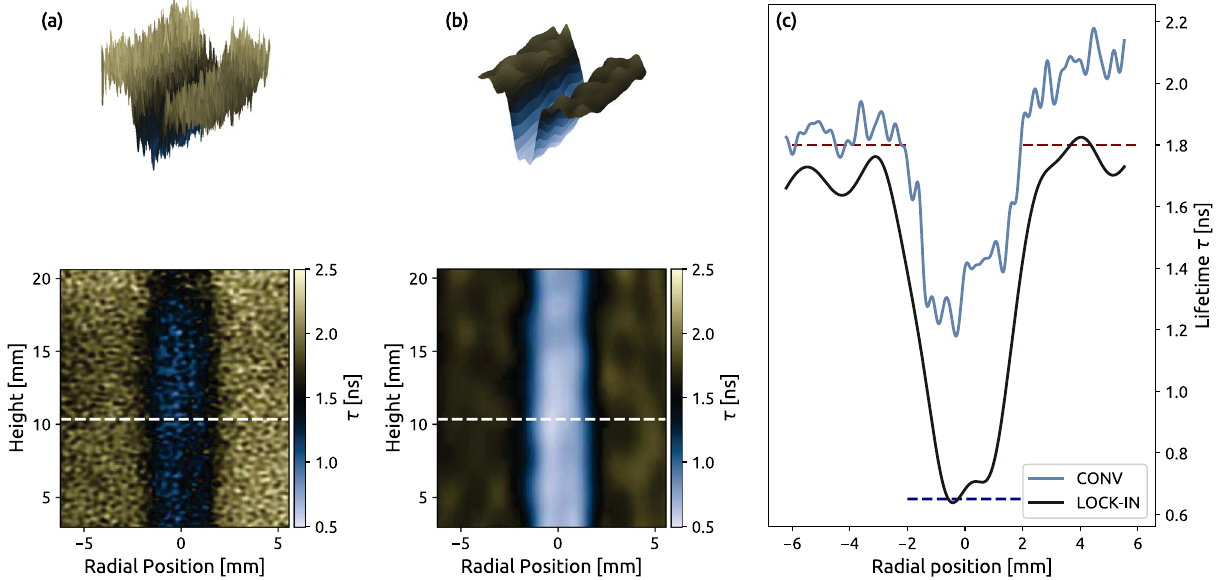
Figure 7. Fluorescence lifetime images for ( a ) conventional, ( b ) lock-in. The 3D plot shows the same data as its corresponding image. In ( c ), data were extracted along the dashed white line in each image and compared in a line plot. The red and blue dashed lines indicate expected values in the co-flow (red) and central jet